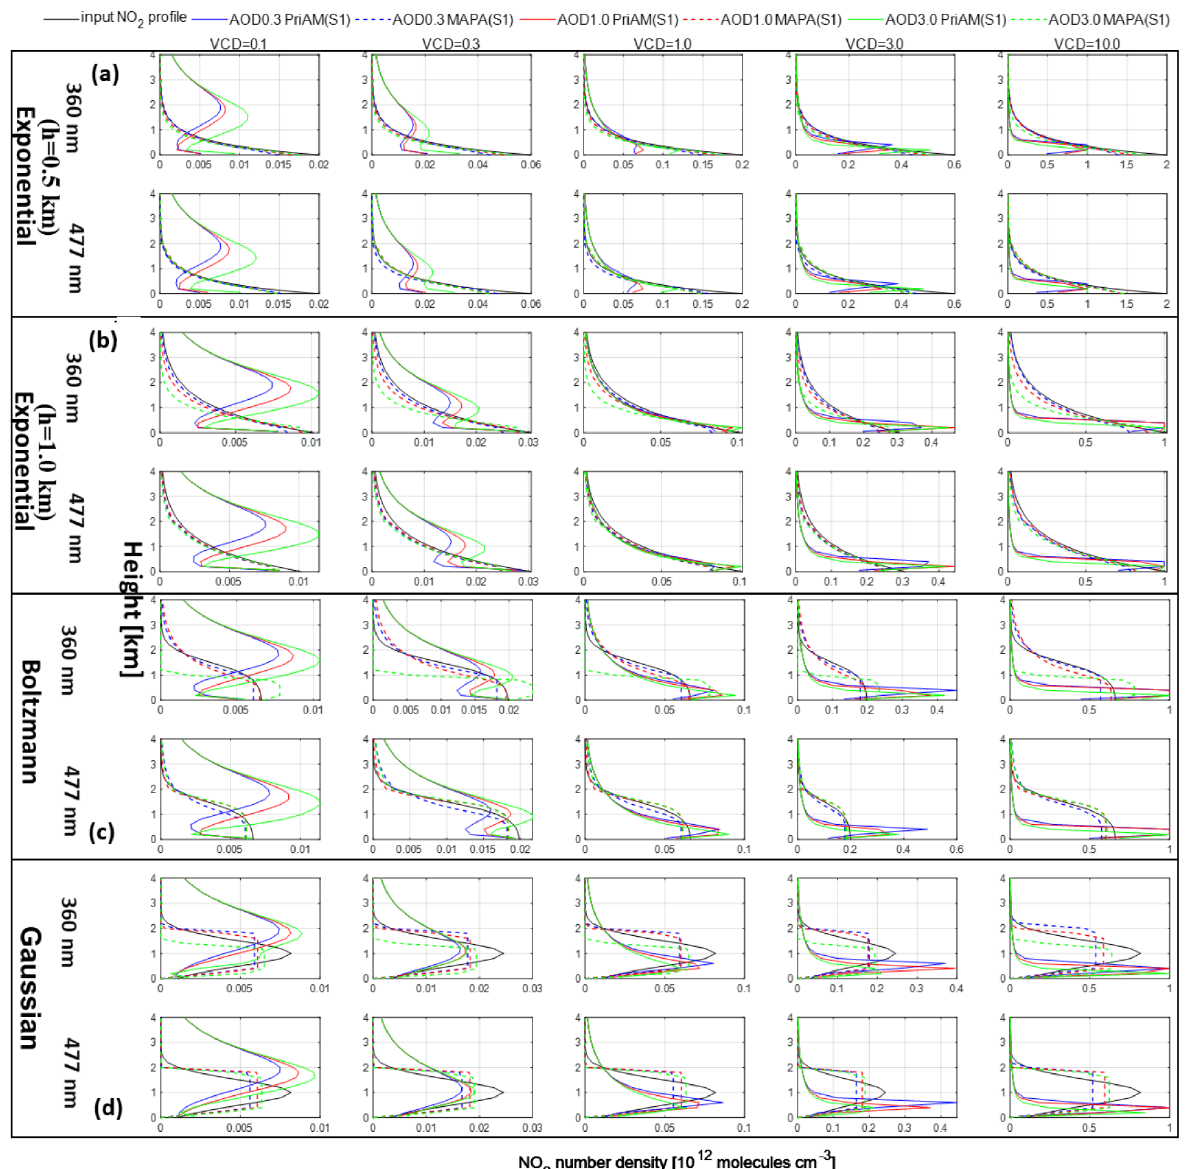
Figure 11. Retrieved NO 2 profiles by PriAM and MAPA for scenario S1 (see text) for aerosol profiles with three selected AODs (0.3, 1.0, and 3.0) and five NO 2 VCDs for of (a) exponential shape with h = 0.5km, (b) exponential shape with h = 1.0km, (c) Boltzmann shape, and (d) Gaussian shape. The solid and dotted colored lines refer to the AODs and algorithms shown at the top.